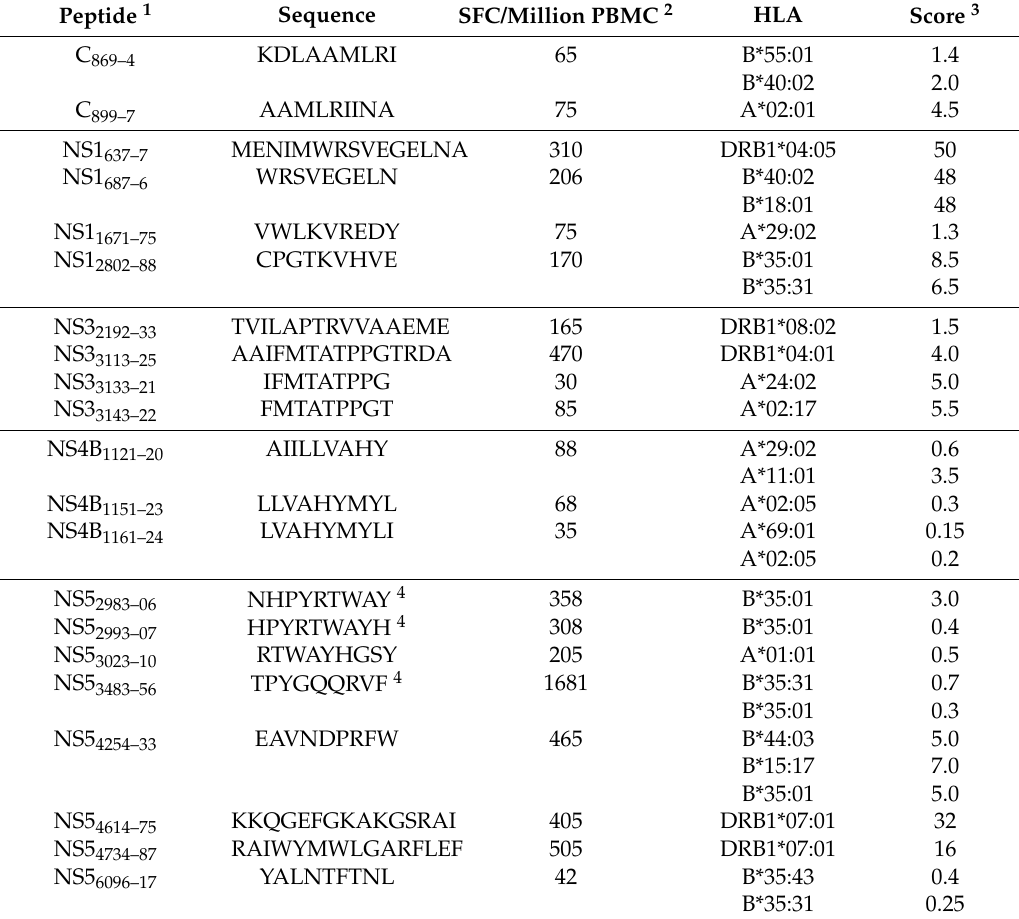
Table 2. HLA class I- or class II-restricted T-cell epitopes identified in ZIKV